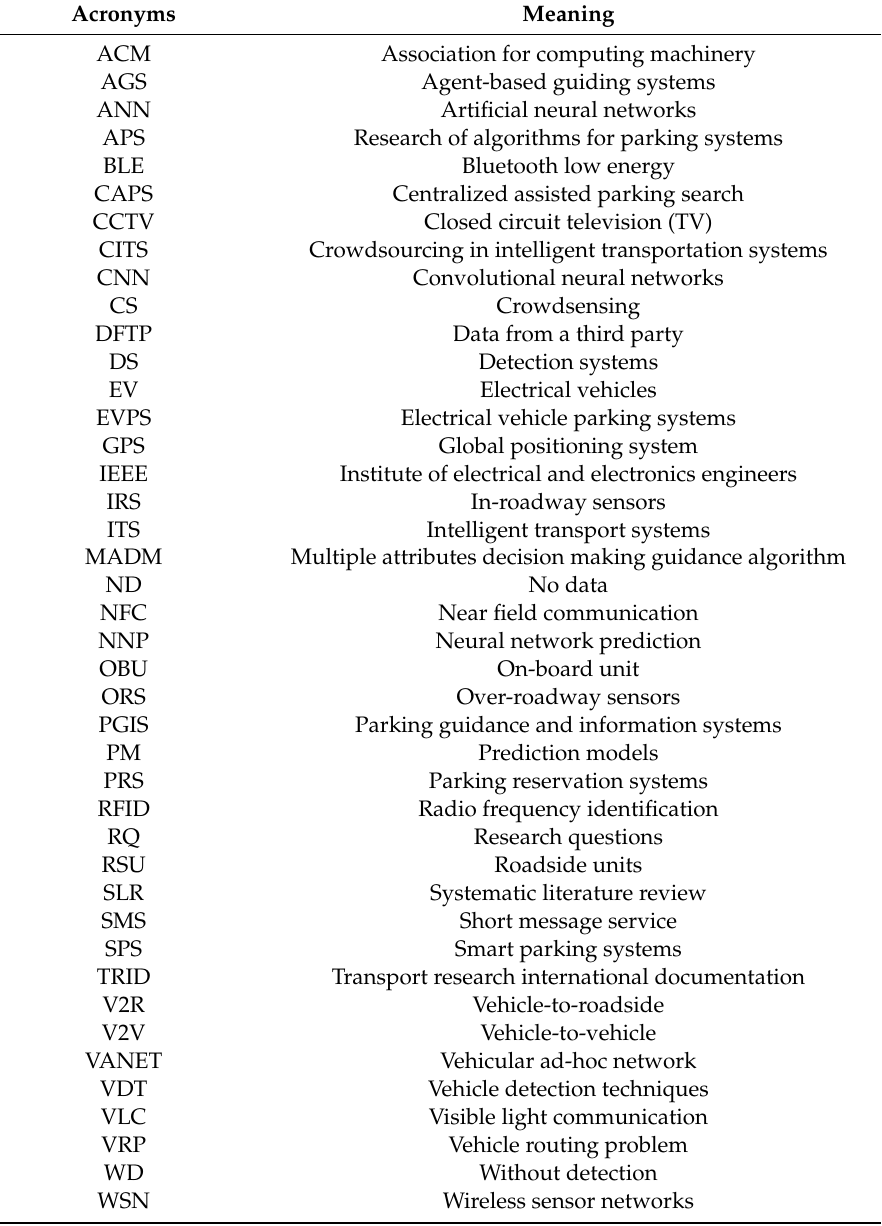
Table 1. Acronyms and their